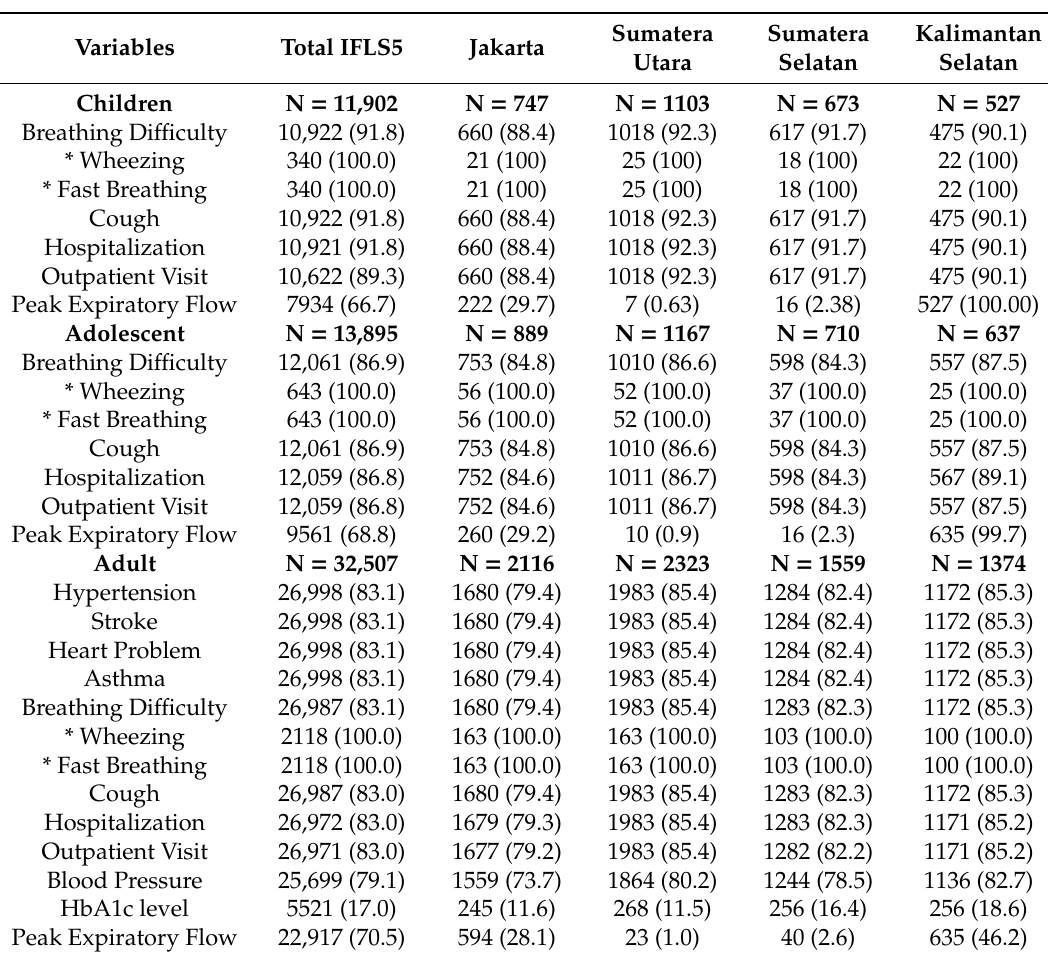
Table 2. Completeness of Health Outcome data-number (%) of total individuals (by age group and selected provinces) for whom data are